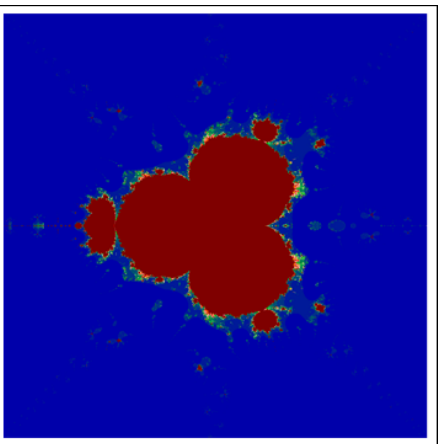
Figure 38. M-set via F-iteration for sin ( z 4 ) + c with image visual time = 175.2 s.